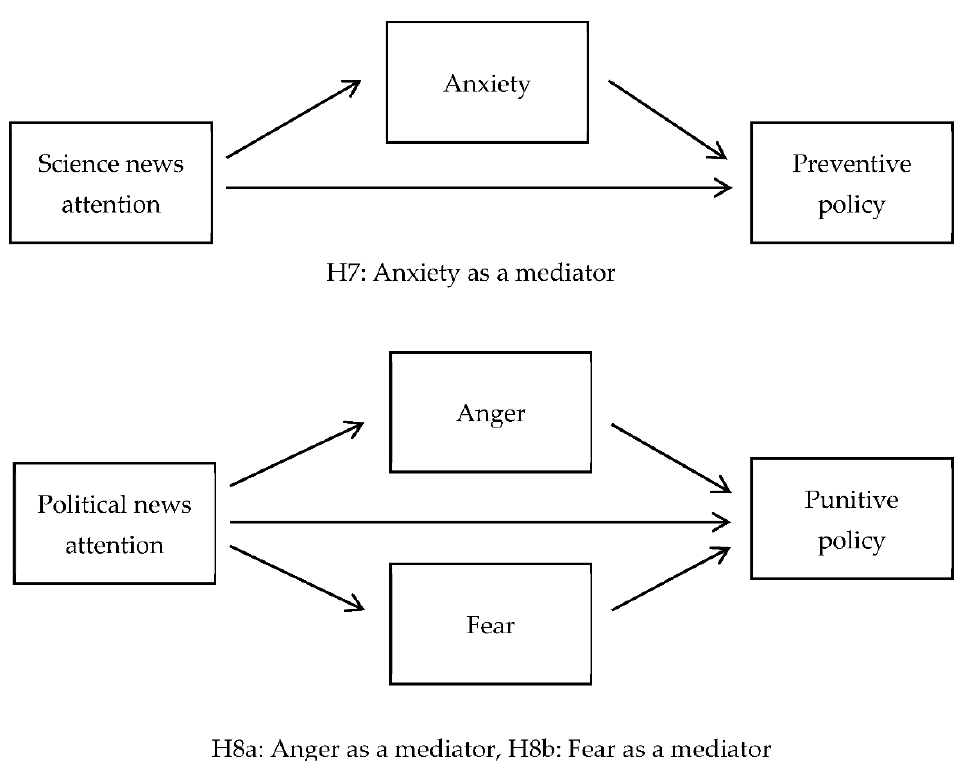
Figure 2. Hypothesized mediation model.